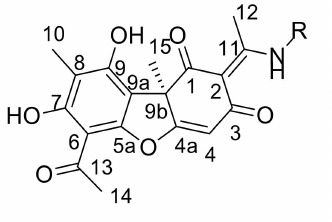
Figure 4. Structures of compounds 11a – e with atom numeration. Table 2. NMR 13 C spectra of 11a – e